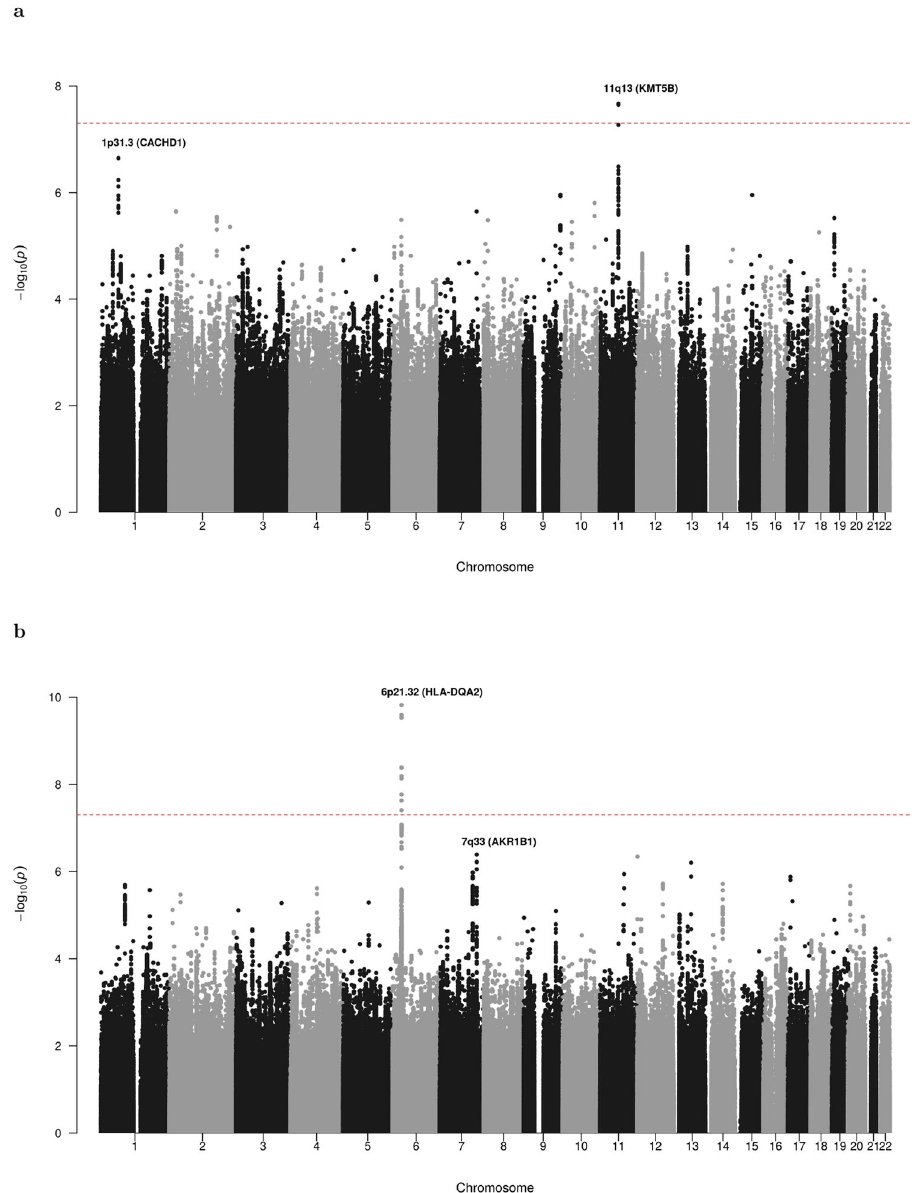
Fig. 1 Manhattan plots from acute myeloid leukemia meta-analysis of 4 genome-wide association studies. For each GWAS, association tests were performed for all AML cases and cytogenetically normal AML assuming an additive genetic model, with nominally signi fi cant principal components included in the analysis as covariates. Association summary statistics were combined for variants common to all four GWAS, in fi xed effects models using PLINK. Manhattan plots show negative log 10 ( fi xed effects meta P values, Y axis) for all AML ( a ) and cytogenetically normal AML ( b ) over 22 autosomal chromosomes. Risk loci are annotated with chromosome position and local gene. All statistical tests were two-sided and no adjustments were made for multiple comparisons. The horizontal red line denotes the threshold for statistical signi fi cance in a genome-wide association study ( P < 5.0 × 10 − 8